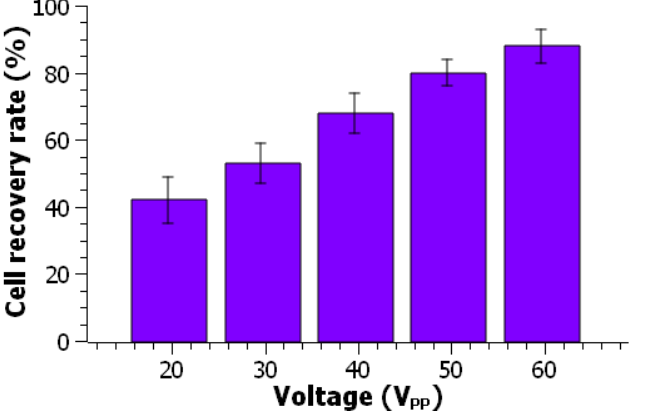
Figure 6. Characterization of HeLa cell recovery efficiency as a function of the applied voltage. Error bars are standard deviation of 5 measurements.